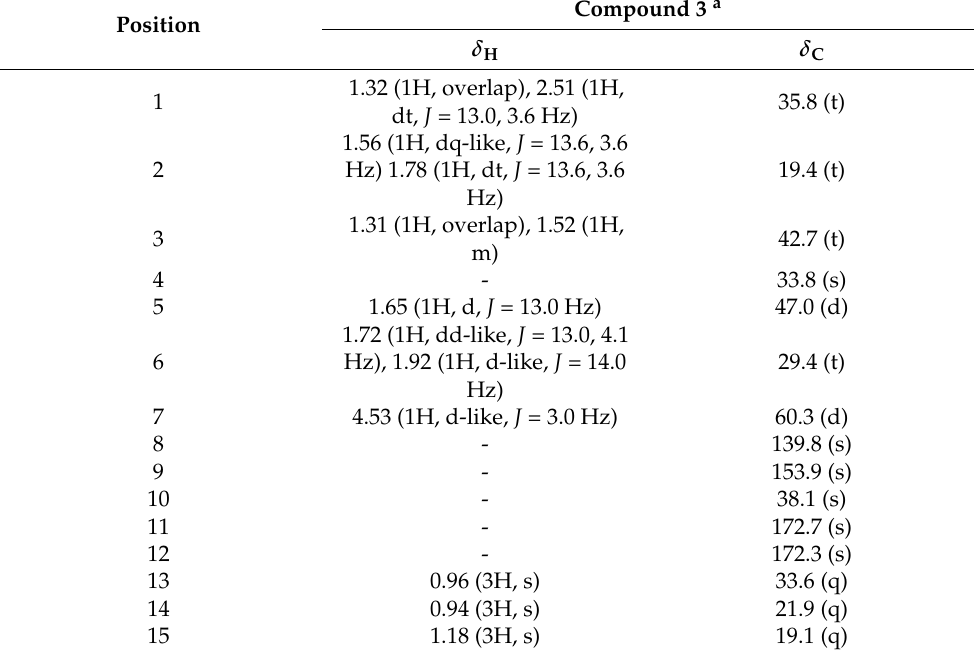
Table 3. 1 H-NMR and 13 C-NMR data for compounds 3 in methanol- d 4 .